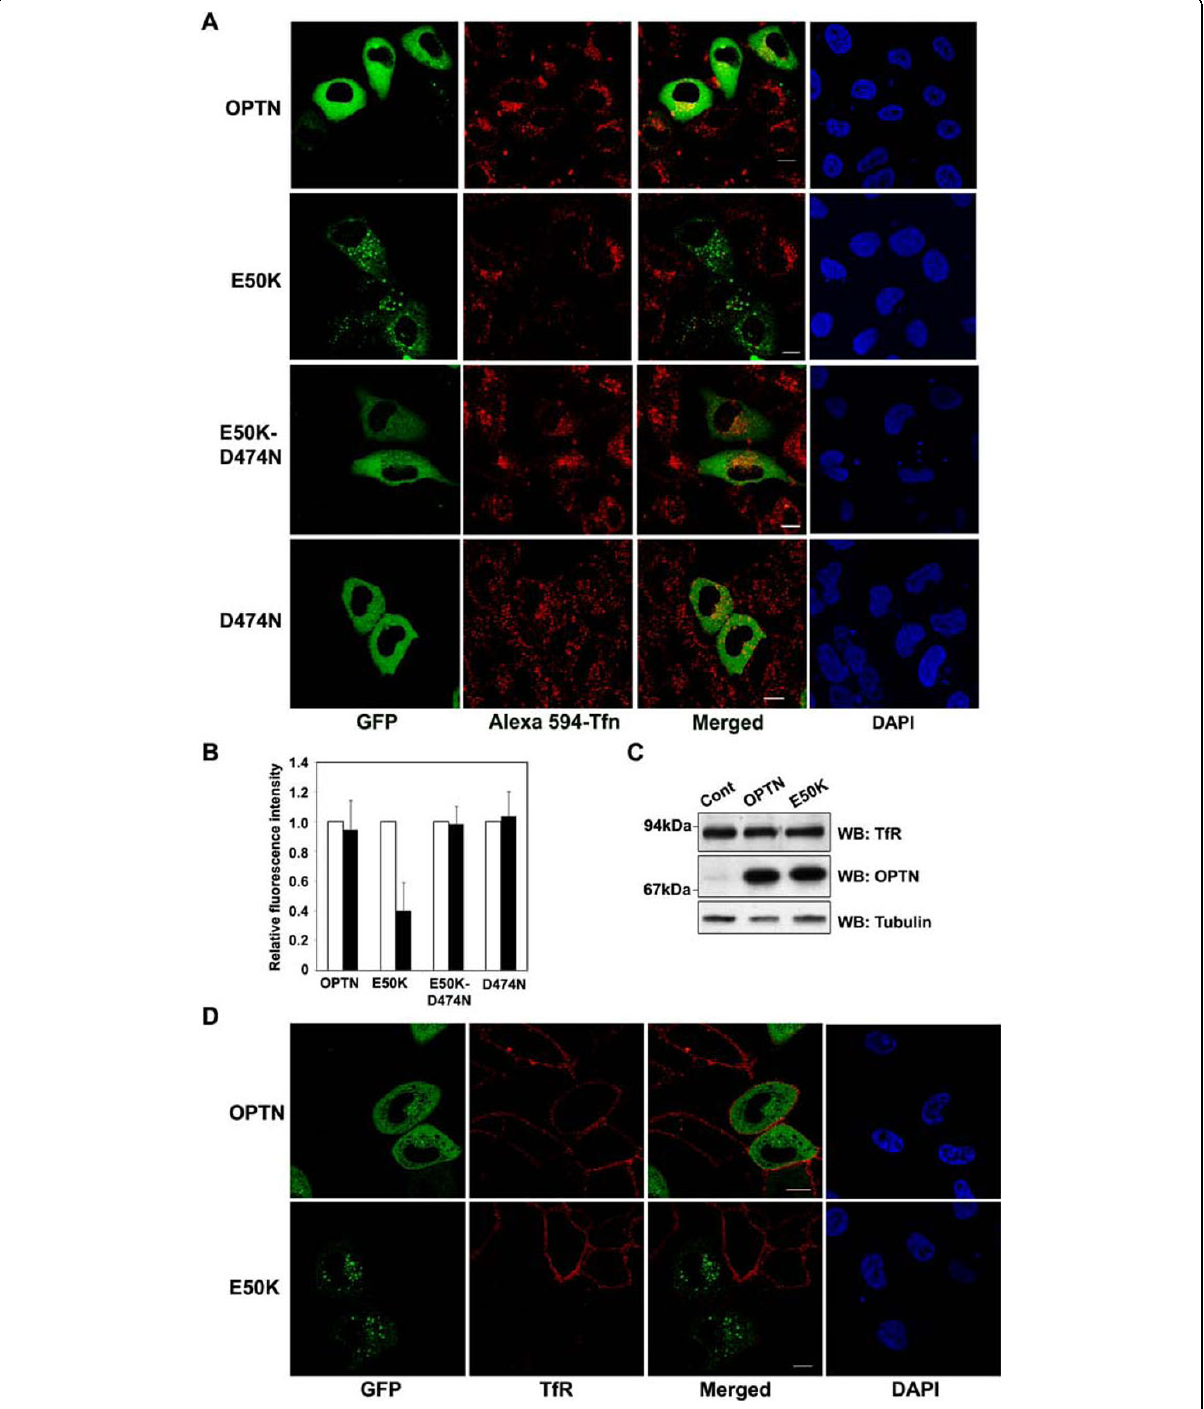
Figure 7 The E50K mutant causes reduced uptake of transferrin . (A) HeLa cells were transfected with GFP- tagged wild type optineurin or its mutants, serum starved and incubated with Alexa-594 conjugated transferrin for 20 min. Cells were then fixed and observed with a confocal microscope. (B) The uptake of labelled transferrin was quantitated by measuring the fluorescence intensity in expressing (filled bar) and non- expressing (empty bar) cells. (C) Western blot showing expression of TfR in cells infected with adenoviruses expressing wild-type or E50K mutant optineurin or control viruses. Western blot shows levels of TfR, optineurin and tubulin. (D) HeLa cells were transfected with GFP-tagged wild-type or E50K mutant optineurin. TfR present at the plasma membrane was visualized by staining these cells without permeablilzation using TfR